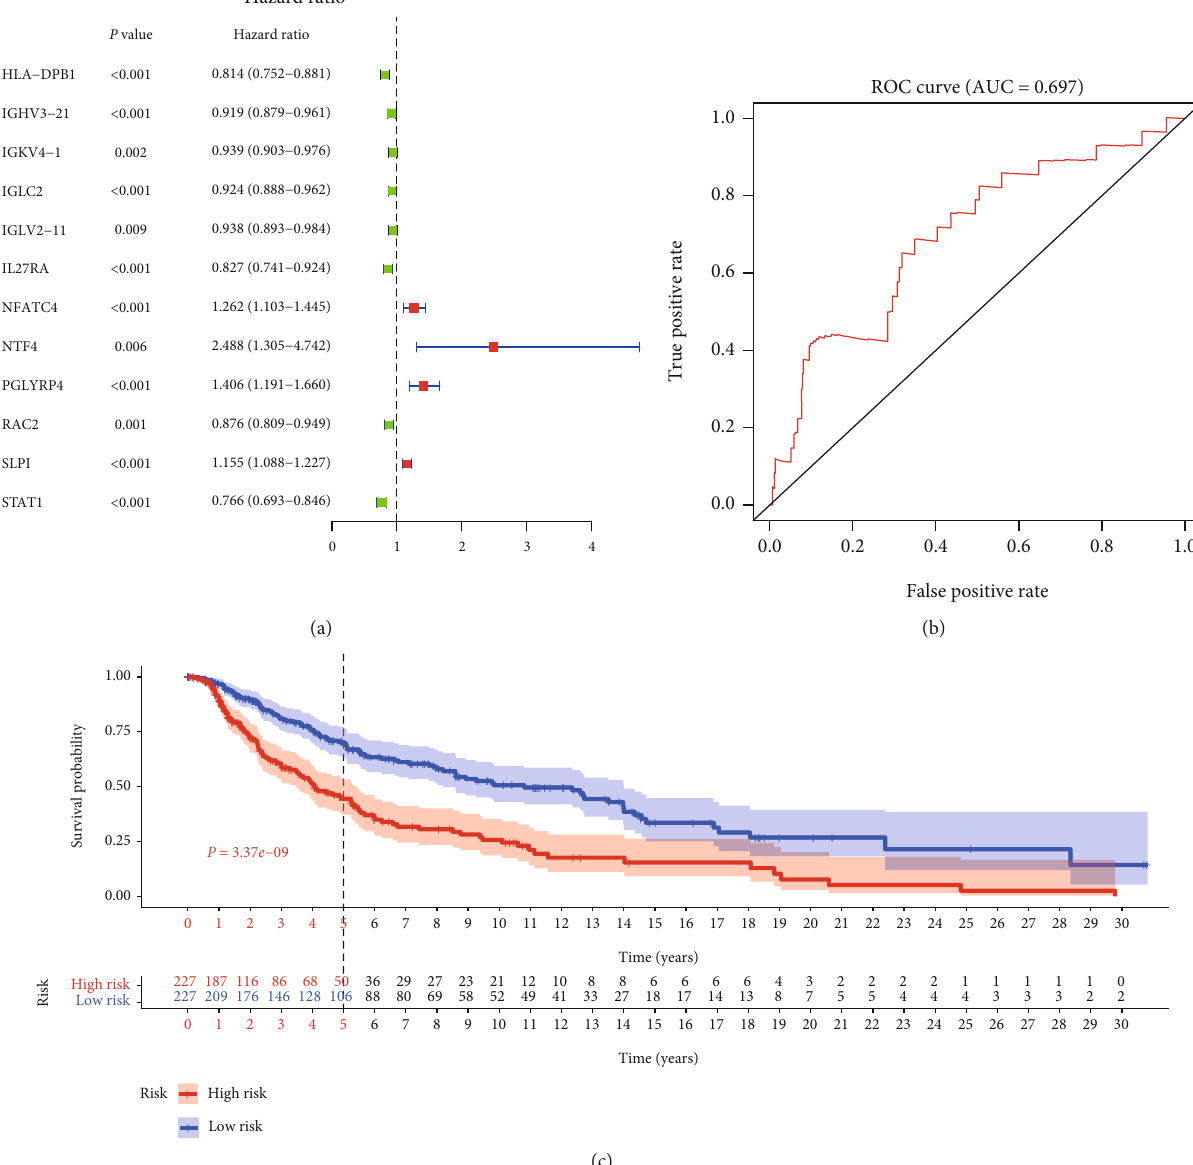
Figure 3: Validation of the risk score prediction model for melanoma prognosis. (a) Results of multivariate Cox analysis of 12 hub immune signatures are illustrated as a forest plot. (b) The 5-year AUC of ROC curve was 0.697, indicating high prediction accuracy. (c) Results of Kaplan-Meier analysis showed that patients in the high-risk group had poor survival outcomes ( P < 0 : 001